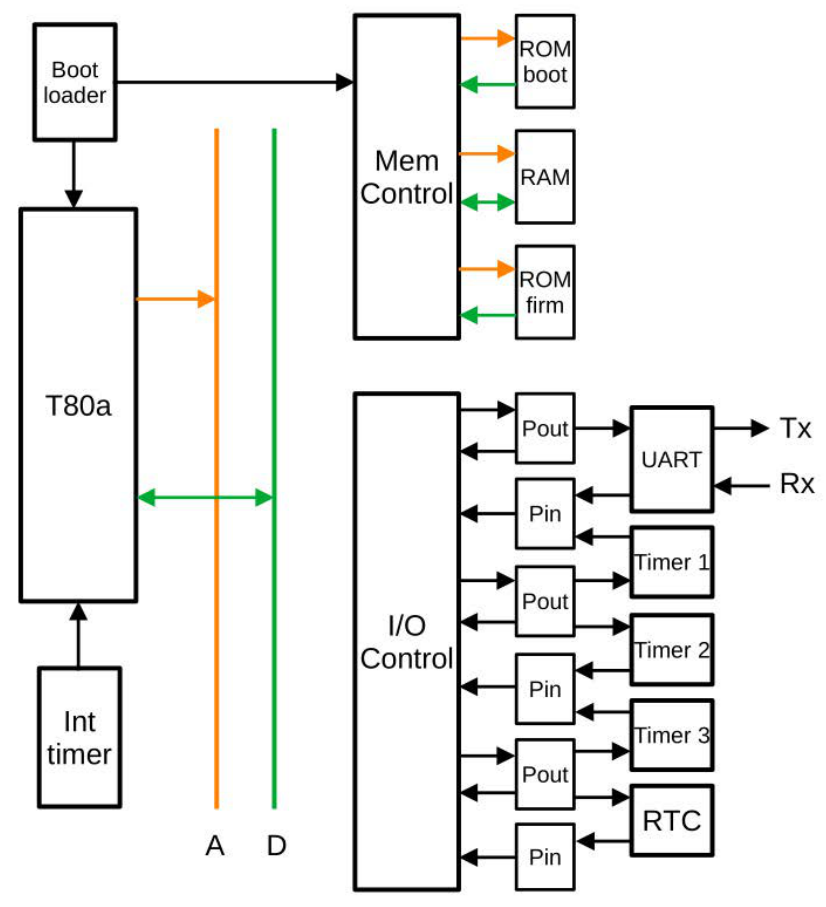
Figure 7. Minimal Dracon block